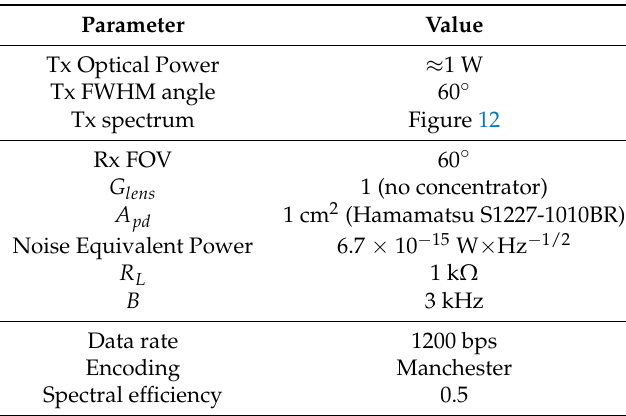
Table 2. Parameters of the implemented VLC